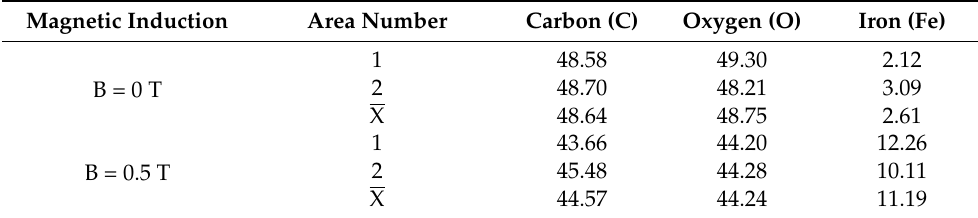
Table 1. Composition (in % of bulk) of composite surfaces (PLA and Fe 3 O 4 ) formed in